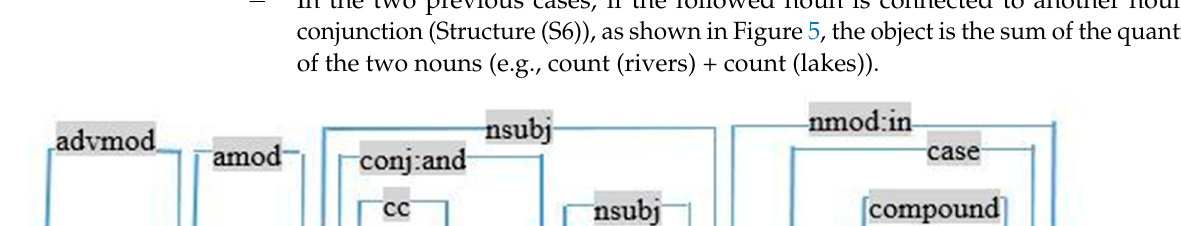
Figure 4. Graph dependency of the query «how many awards has Bertrand Russell».